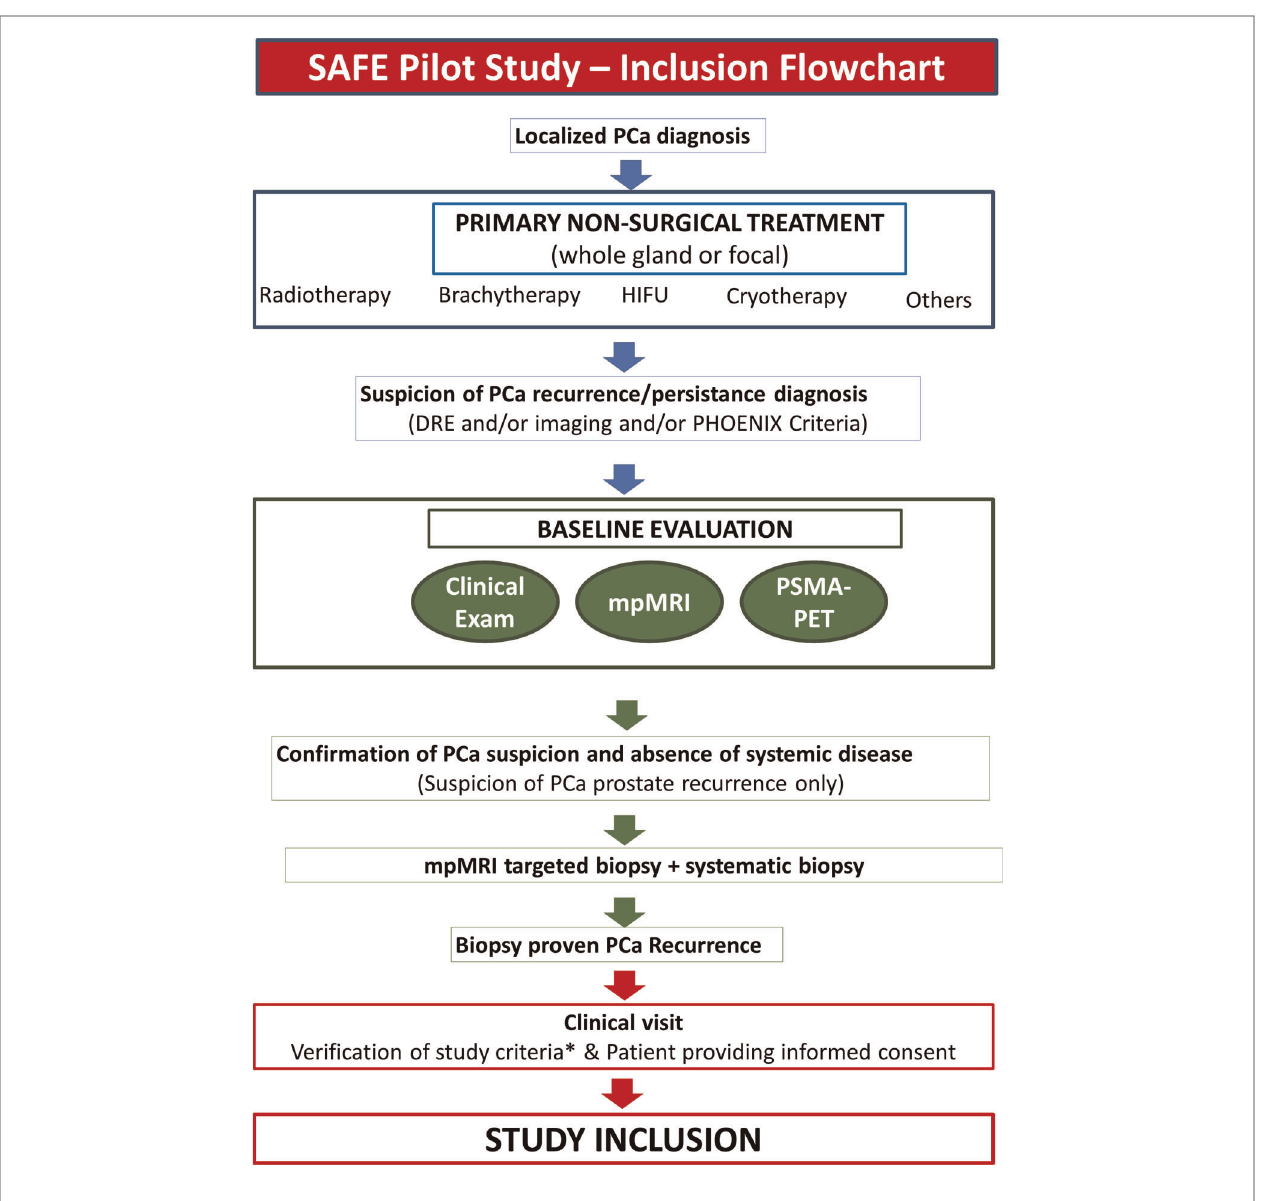
FIGURE 1 | Flowchart illustrating the different steps from patient referral to study